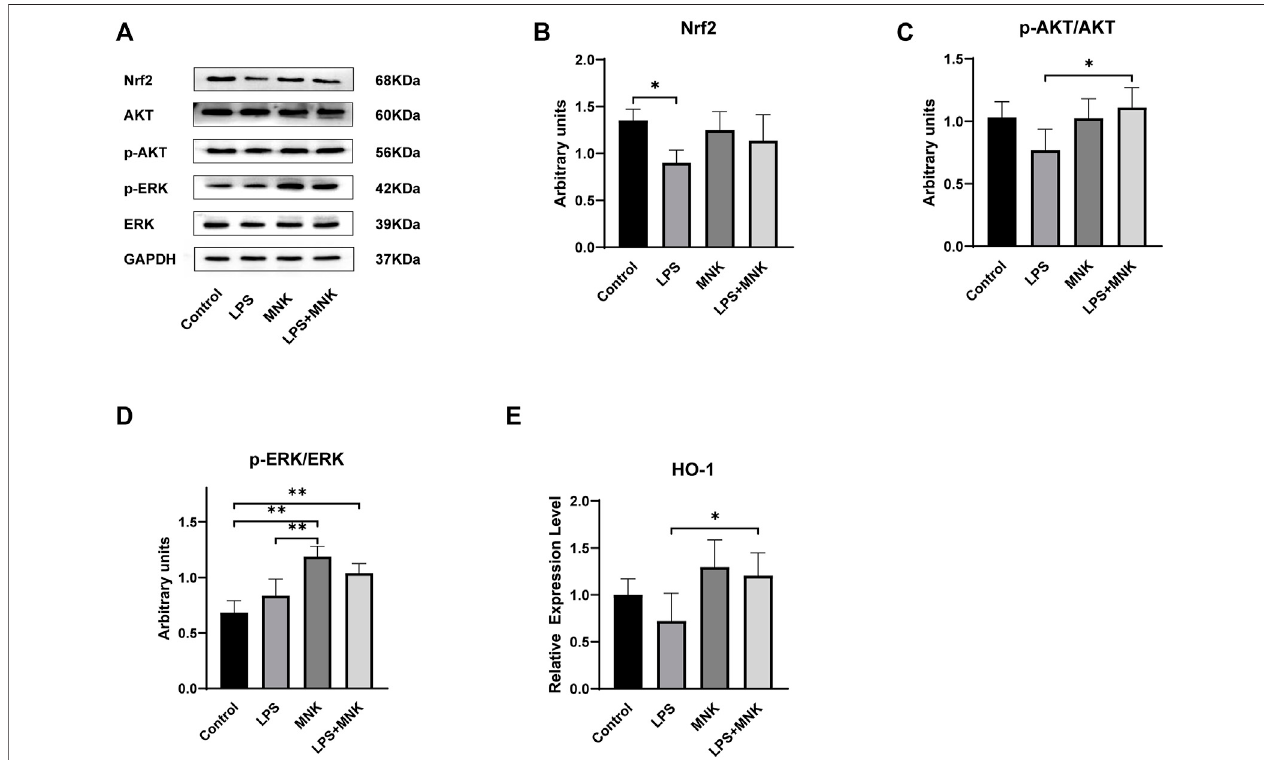
FIGURE 7 | The effects of 2-methyl nonyl ketone (MNK, 10 μ g/ml) on the levels of Nuclear factor erythroid 2-related factor 2 (Nrf2) signaling pathway induced by lipopolysaccharide (LPS, 100 μ g/ml) in MAC-T cells. (A) The expression of the Nrf2 signaling pathway was measured using Western blot. (B) Nrf2. (C) p-AKT/AKT. (D) p-extracellular signal-regulated kinase (ERK)/ERK. (E) The mRNA relative expression levels of Heme Oxygenaseoxygenase-1 ( HO-1 ). GAPDH was used as an internal reference for Western blotting analysis. The data are shown as mean ± SD. N (cid:1) 3. *, p < 0.05; **, p < 0.01.